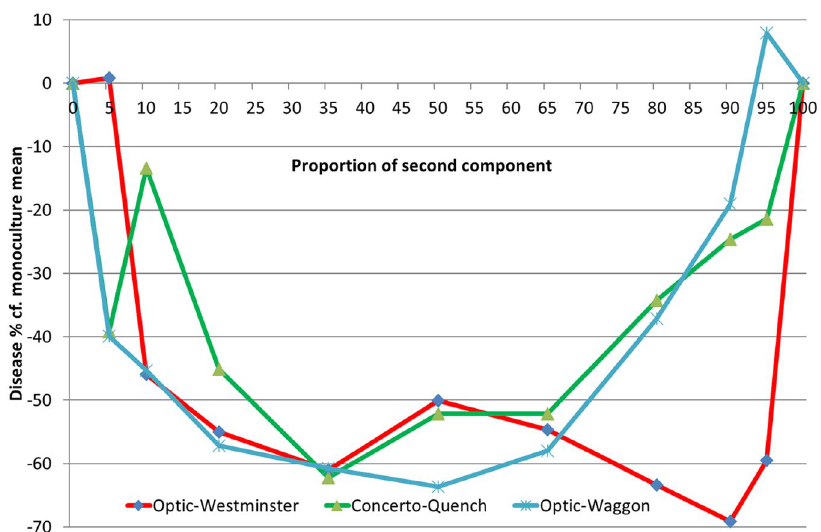
Figure 2. Disease reduction compared with the weighted component monoculture mean for three replacement series of 2-component mixtures no fungicide treatment.